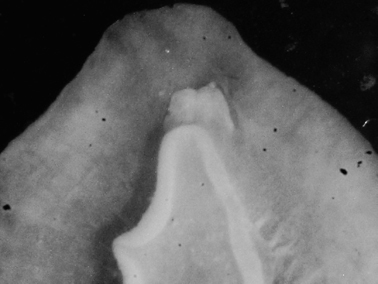
Phyllidiopsis gemmata, 33 mm (NY-35), view of propodium, head, and oral tentacles.